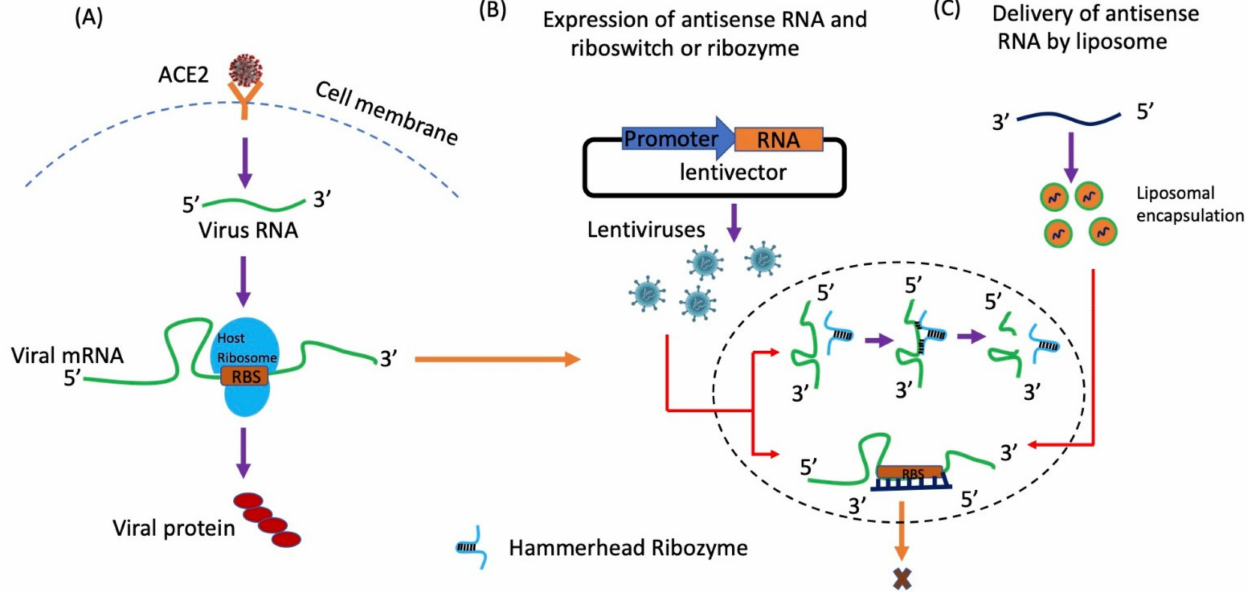
Figure 5. Antisense RNA approach to block translation of SARS-CoV-2 (cid:48) s mRNA. ( A ). Entry of SARS-CoV-2 inside the cell and virus mRNA released and mRNA of virus translate the virus protein. ( B ). The lentivirus expressing antisense RNA or riboswitch or ribozyme that can bind on virus mRNA and block translation. ( C ). Delivery of antisense RNA by liposomes. Expression of antisense RNA can block the translation of viral